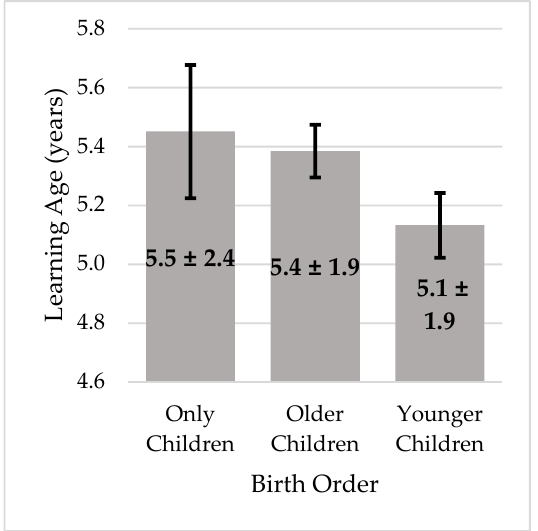
Figure 2. Mean age and standard deviation to learn how to cycle according to the birth order (error bars represent 95% CI).